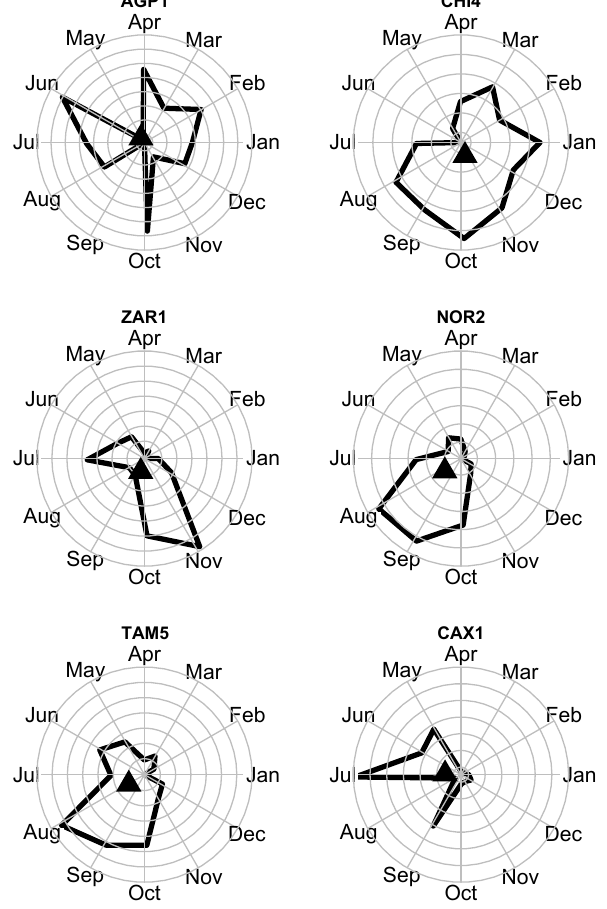
Fig. 1. Seasonality patterns for total litterfall at six sites (for site names, see Table 1). Thick lines delineate the envelope of monthly litterfall. The sites are ranked by increasing seasonality from left to right and top to bottom. Seasonality was measured using the equations reported in the Methods.